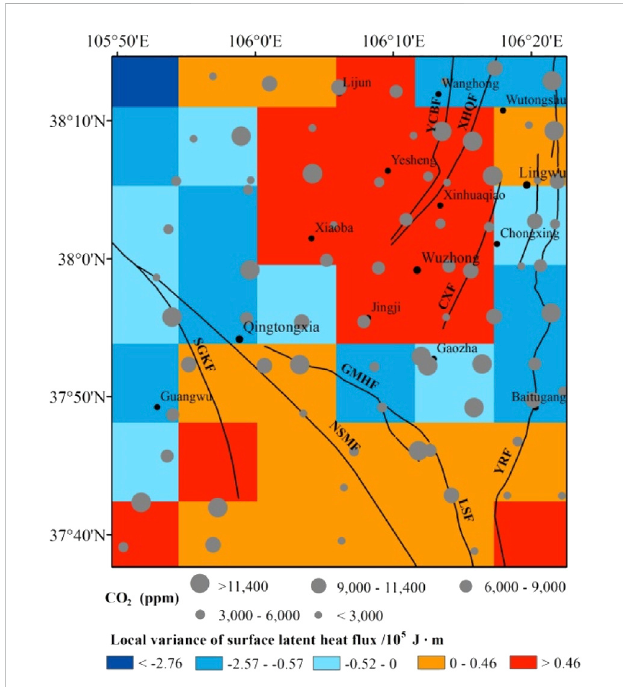
FIGURE 6 Relationship between the spatial distribution of surface latent heat – Lingwu fl ux (SLHF) and CO 2 in the Wuzhong